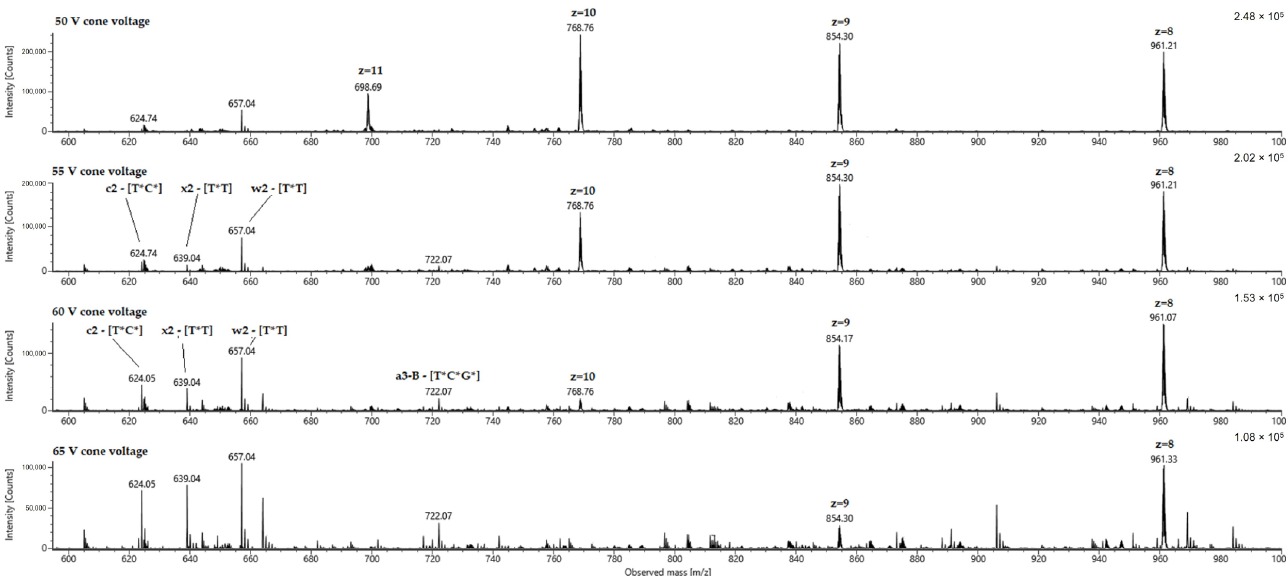
Figure 3. Fragmentation of a 24 nt fully thiolated oligonucleotide via increase of cone voltage. Multiple charged state signals are highlighted and fragments labelled according the McLuckey et al. [19].